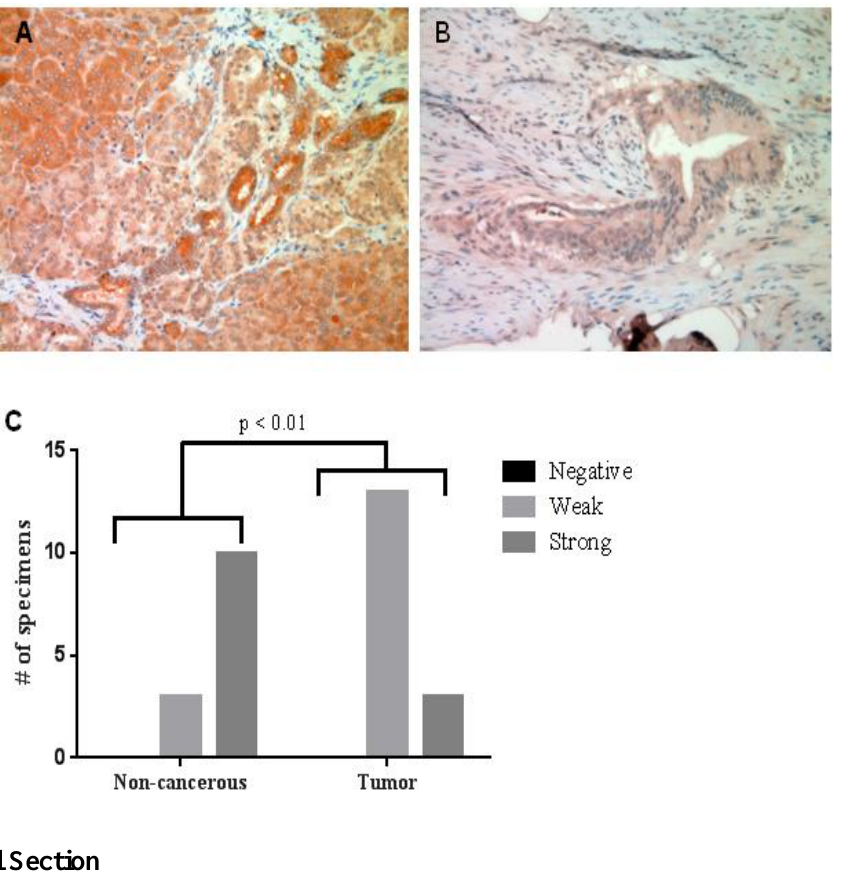
Figure 6. IP10 expression in pancreatic tumor specimens. IP 10 immunohistochemistry staining shows IP10 expression was down-regulated in tumor tissue ( B ) compared with non-cancerous, tissue ( A ) . ( C ) Fisher’s exact test shows the quantitative staining intensity difference between tumor and normal tissue is significant ( p <